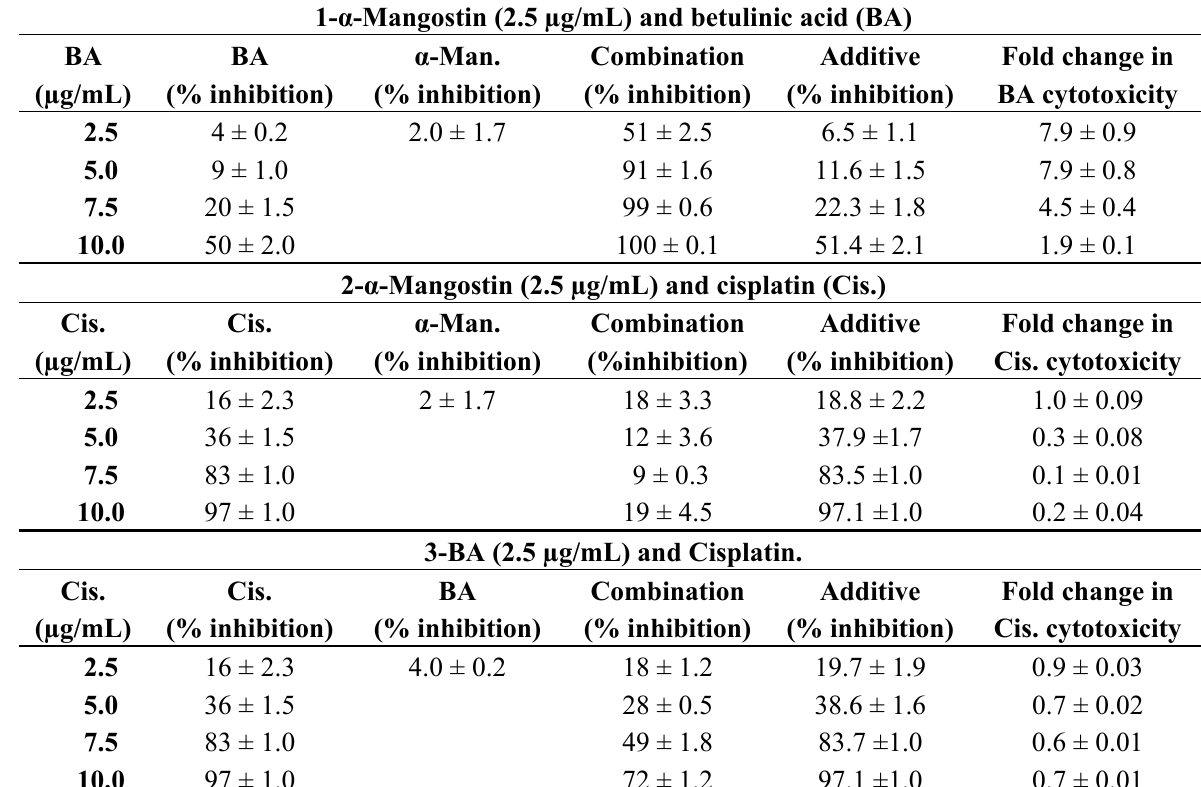
Table 1. Summary of the cytotoxic effect of α -mangostin, BA, and cisplatin and their combinations on HCT 116 cells. The table presents the percentage inhibition of individual treatments and their combinations, and the fold change in the cytotoxicity of combinations compared to their additive cytotoxicity. The results are displayed as average ± SD (n =